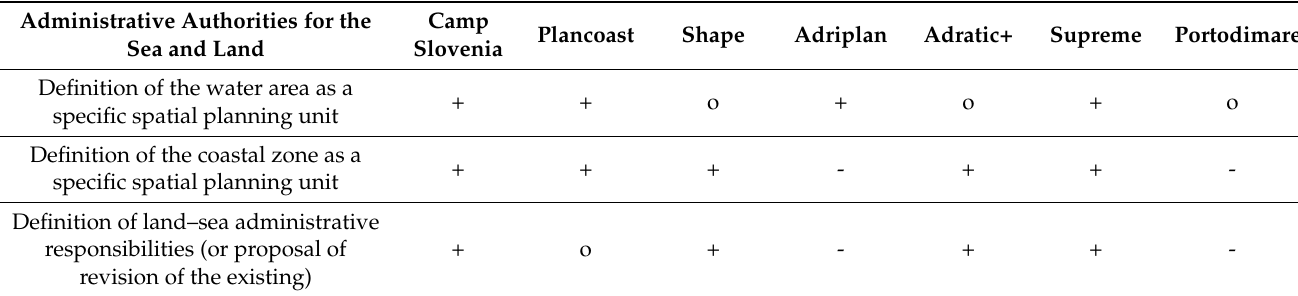
Table 9. Comparison of the draft plan and individual projects: identification and examination of administrative spatial entities and administrative